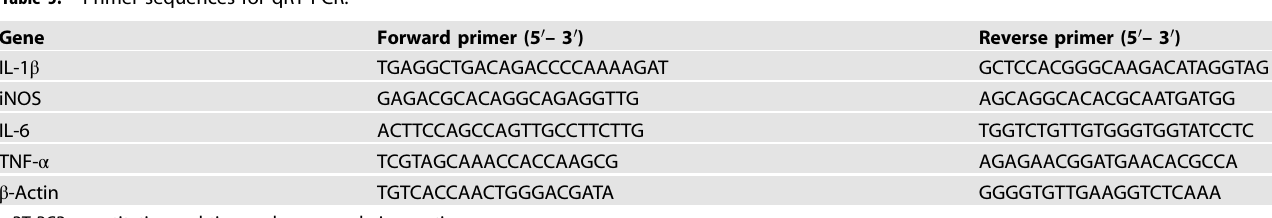
Table 3. Primer sequences for